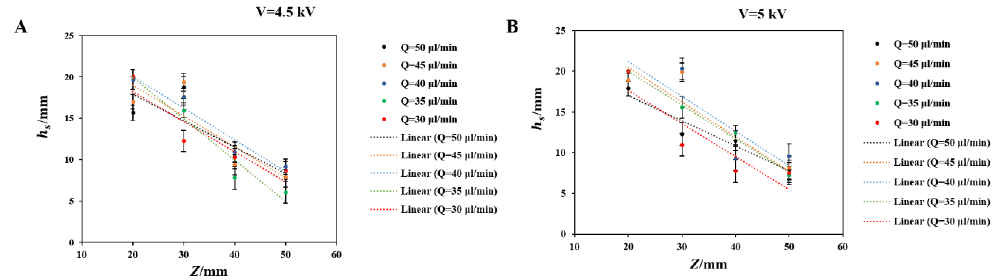
Figure 4. The experimental points and trendlines in the h s –Z plane under different voltage: ( A ) V = 4.5 kV, ( B ) V = 5 kV.